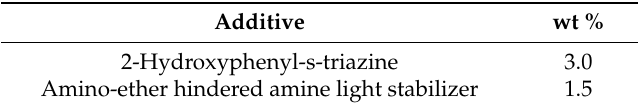
Table 3. UV protection of the formulations.